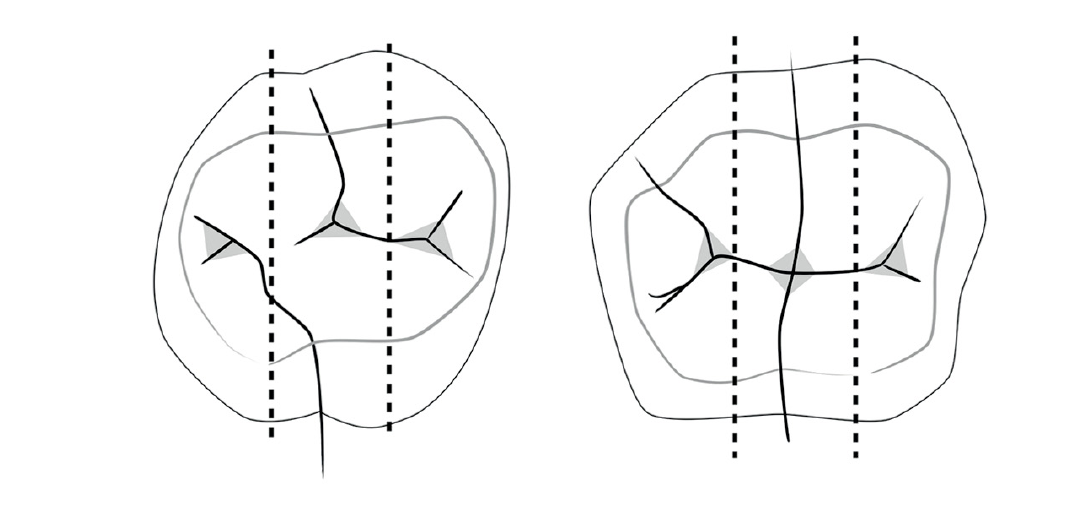
Figure 2. Schematic illustration of the division of the occlusal surfaces of first permanent molars into three sections. Each section was separately assessed for retention of